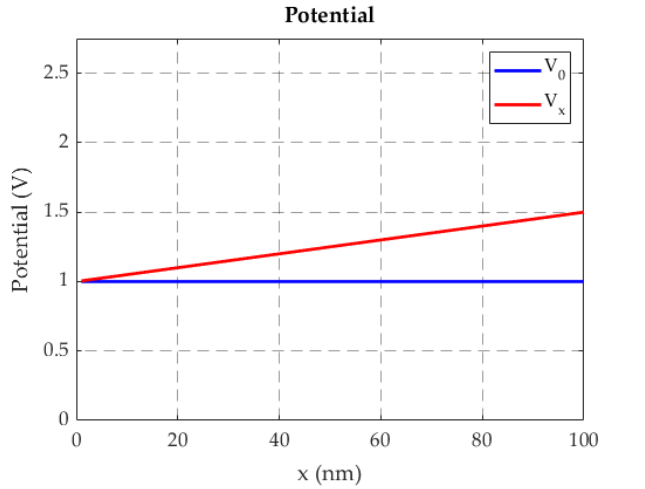
Figure 1. Potential in the structure (Sample length L x = 100